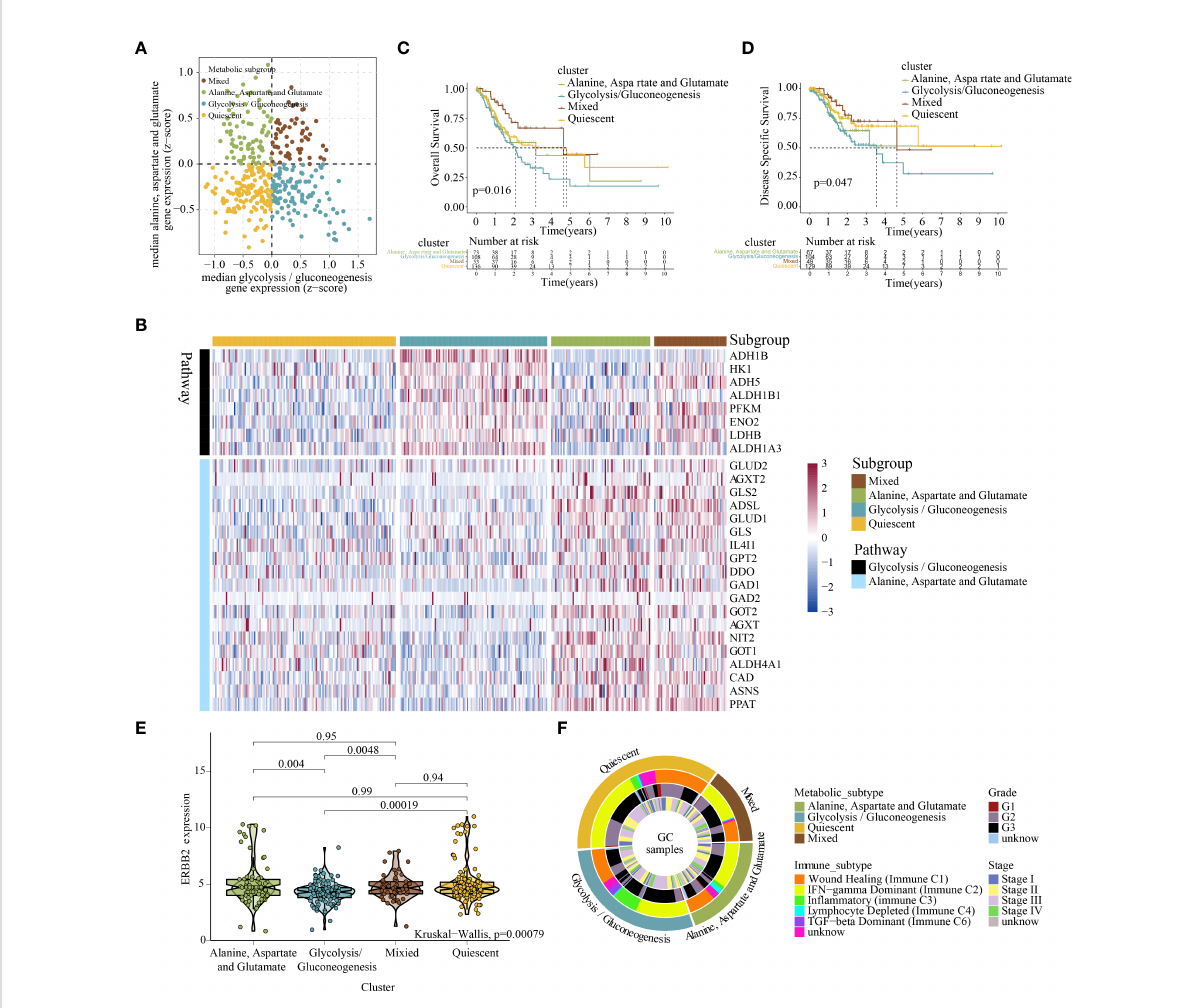
FIGURE 4 Classi fi cation of the metabolic subtypes of GC based on the expression of alanine – aspartate – glutamate and glycolysis/gluconeogenesis metabolism-related genes. (A) Scatter plot showing the median expression levels of coexpressed glycolysis/gluconeogenesis (X-axis) and alanine – aspartate – glutamate (Y-axis) metabolism-related genes in each GC sample. Metabolic subgroups were assigned based on the relative expression of glycolysis/gluconeogenesis and alanine – aspartate – glutamate metabolism-related genes. (B) Heatmap depicting the expression levels of coexpressed glycolysis/gluconeogenesis and alanine – aspartate – glutamate metabolism-related genes in each subgroup. (C, D) Kaplan – Meier survival analyses (OS and DSS) of patients with GC strati fi ed based on metabolic subgroups. (E) Violin plot demonstrating ERBB2 expression in the four metabolic subtypes. (F) Overlay of metabolic subtypes (outer ring) with well-recognised immune subtypes of GC, tumour stage and tumour grade (inner